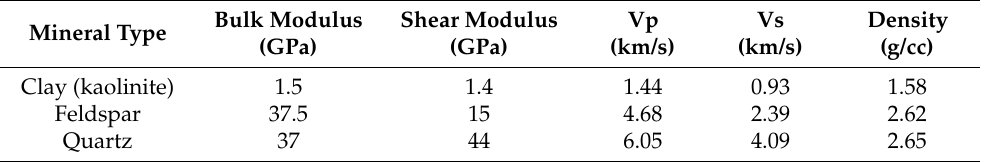
Table 1. Elastic parameters and density of common minerals [12].